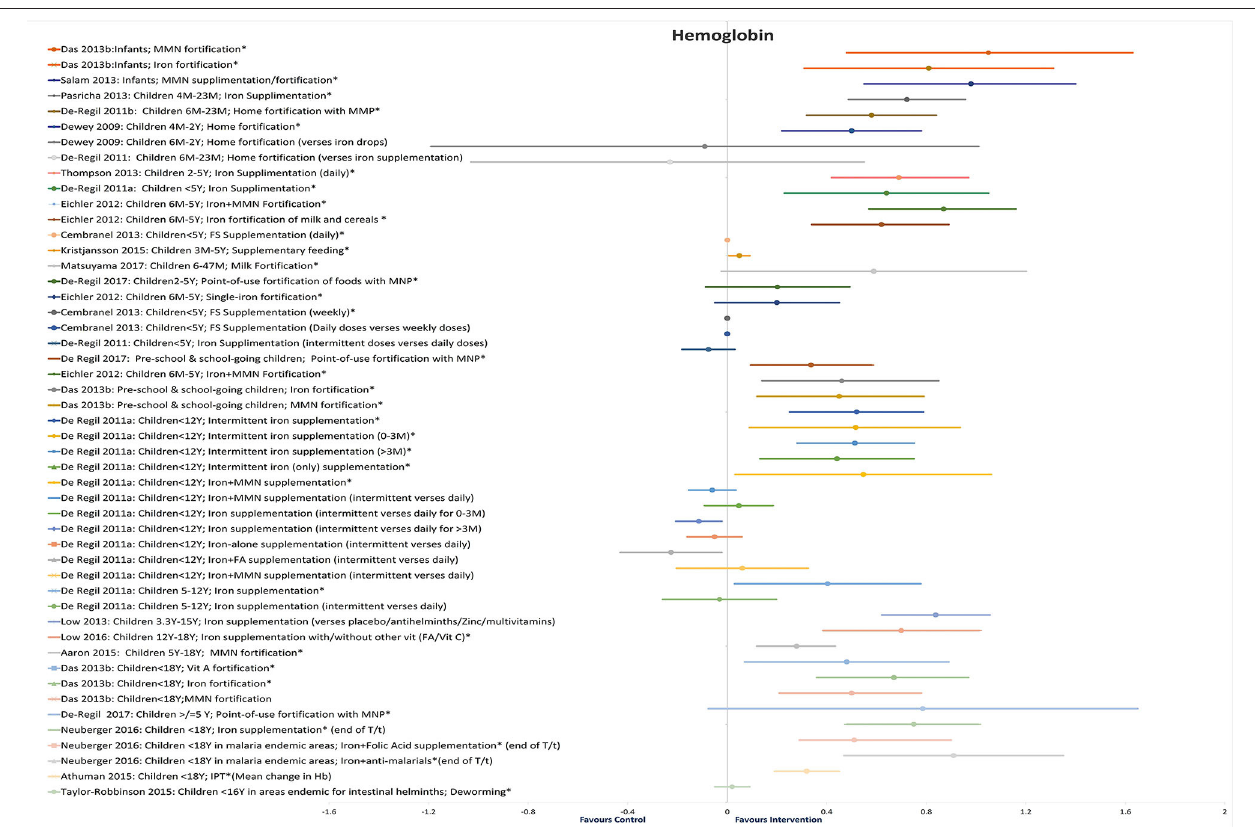
FIGURE 3 | Findings of SRs on